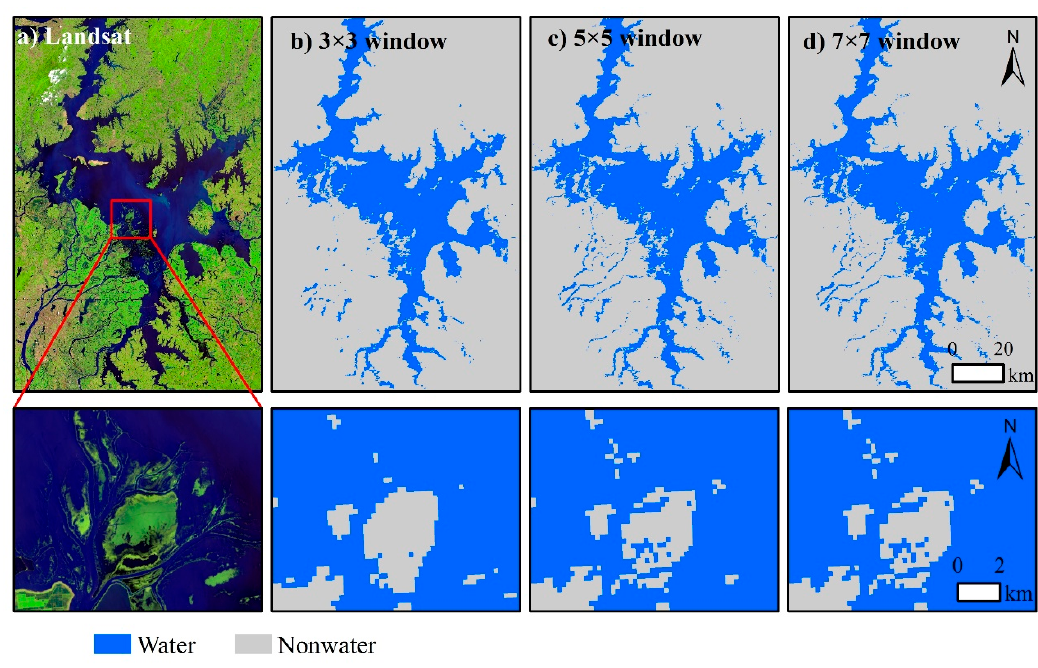
Figure 7. An illustrative example to compare water results for different windows in Poyang Lake. ( a ) False color composite on 23 June 2016. Fusion results on 2016169th day with ( b ) 3 × 3, ( c ) 5 × 5, and ( d ) 7 × 7 windows.